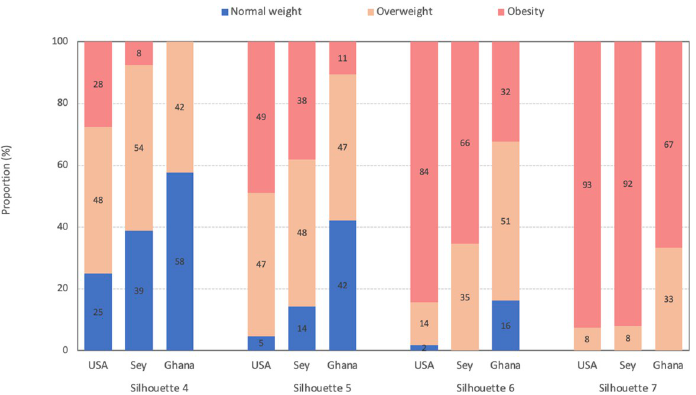
Fig 2. Proportion with normal weight, overweight, and obese within each silhouette category in the US, Seychelles, and Ghana. N weight: normal weight (BMI 18.5–24.9 kg/m 2 ); Overweight (BMI 25.0–29.9 kg/m 2 ); Obese (BMI � 30 kg/m 2 ); Sey: Seychelles.